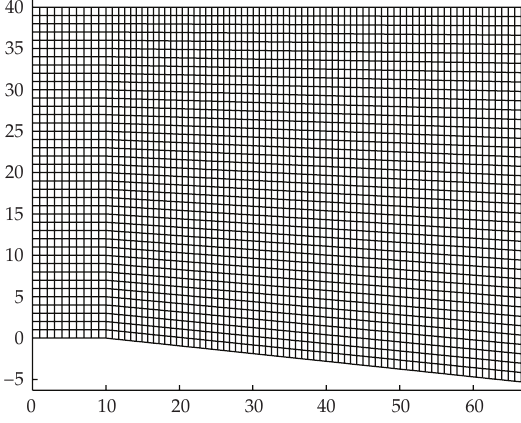
Figure 5: Mesh generated for the expansion